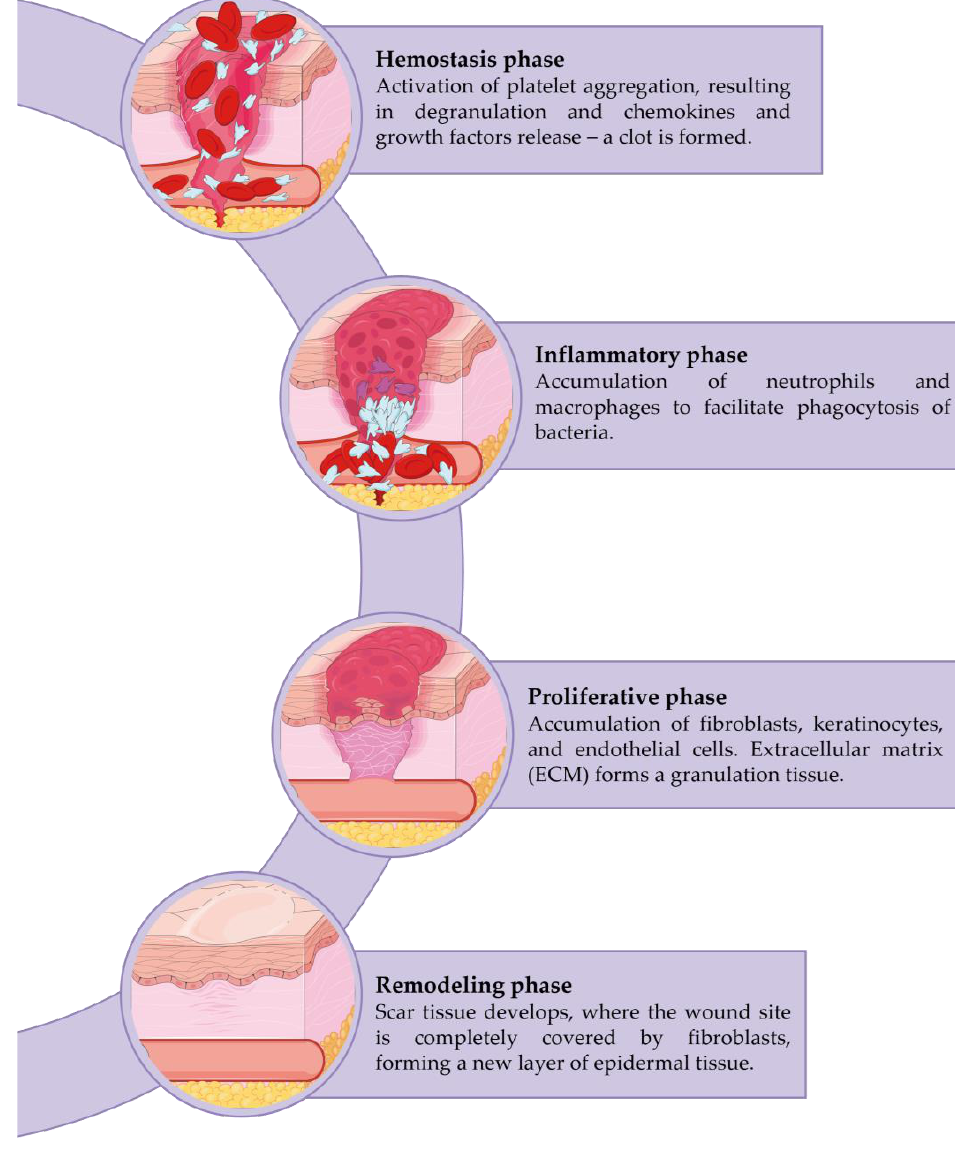
Figure 1. Phases of the wound healing process. Created with SMART — Servier Medical ART. Available online: https://smart.servier.com (accessed on 5 December 2022).